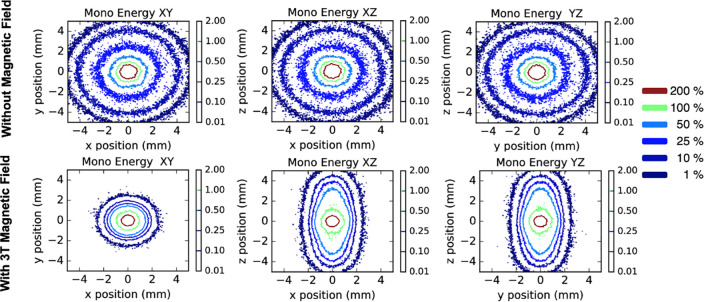
Monoenergetic electron source (432 keV) in a homogeneous lung environment.Normalized dose distributions in a homogeneous lung-tissue phantom for a monoenergetic electron source. Results are shown in absence of a magnetic field (top row), and under the presence of a 3 T magnetic field (bottom row) oriented on the positive z-axis. Simulations are limited to ± 5 mm regions in their corresponding planes.